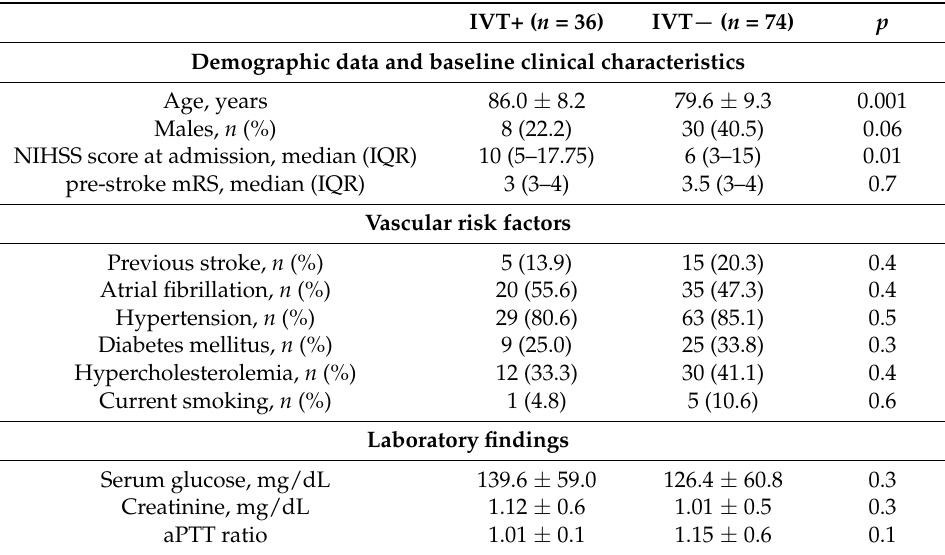
Table 1. Baseline characteristics.